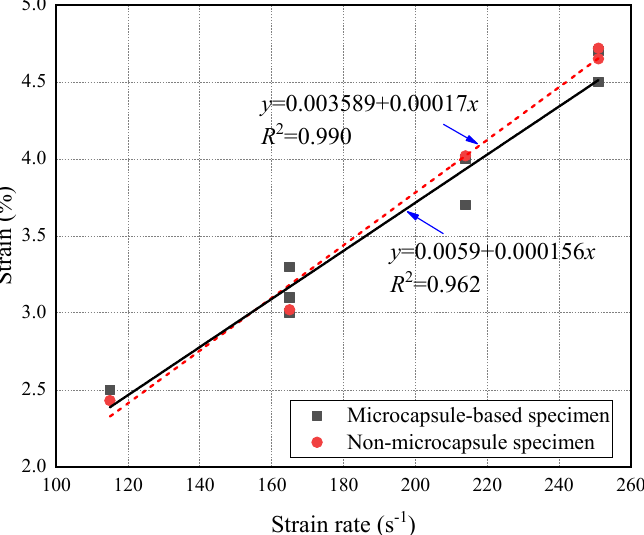
Figure 9. Peak strain under various strain rates.